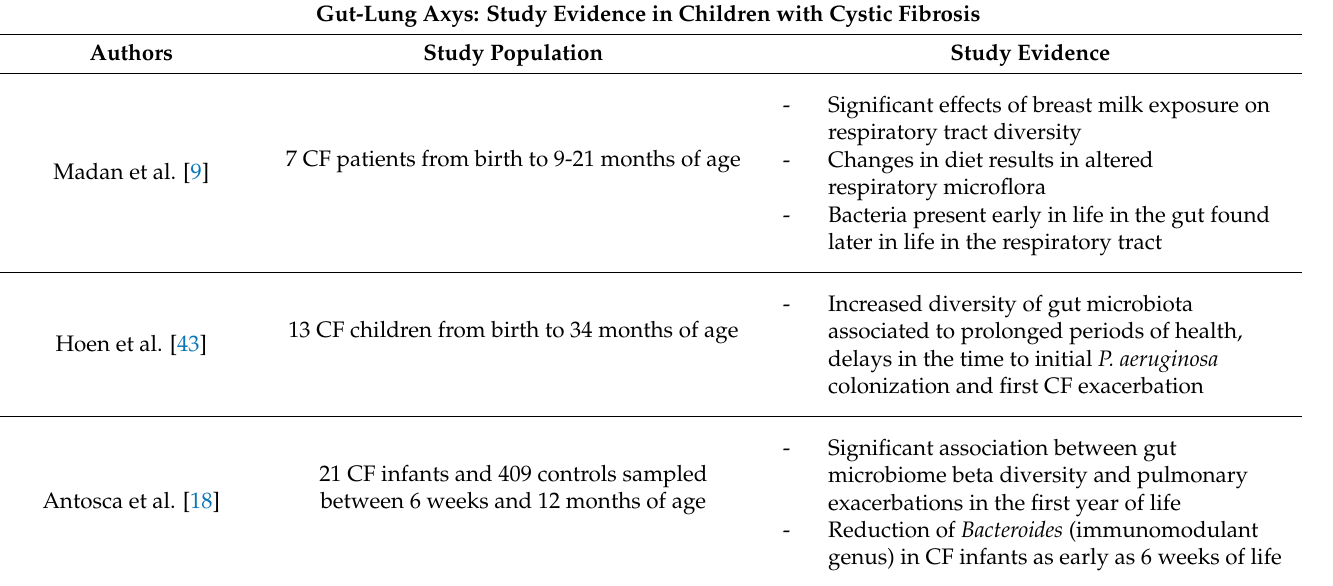
Table 2. Study evidence on gut–lung axis in CF